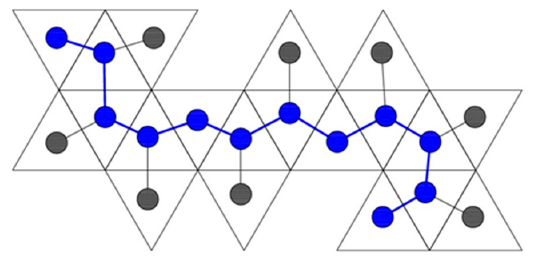
Figure 19. A skeleton graph with its backbone drawn overtop the spanning tree in blue.